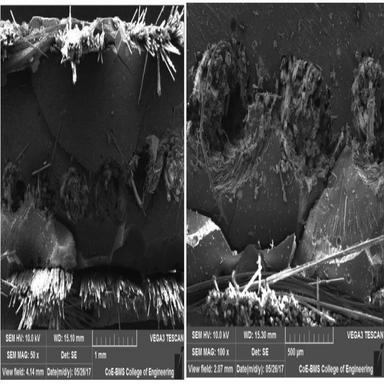
(a)–(e) SEM images of the fractured specimens.